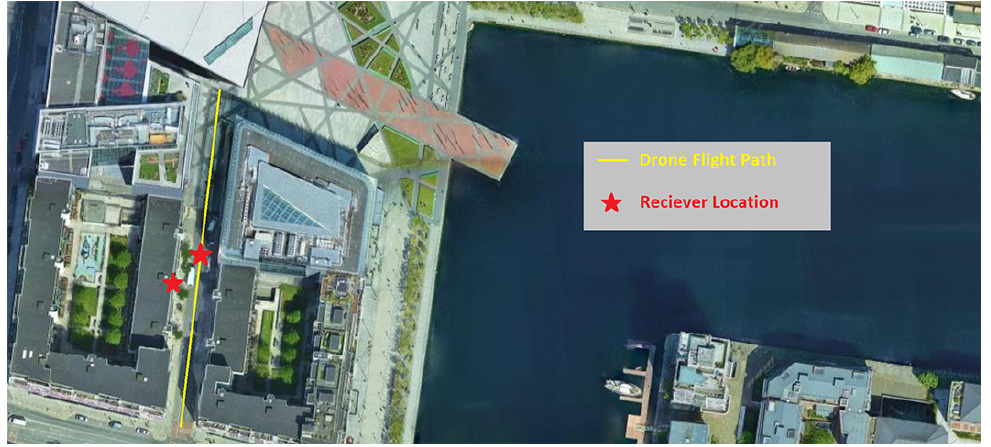
Figure 9. Layout of the case study site location 53.343253 N, − 6.239823